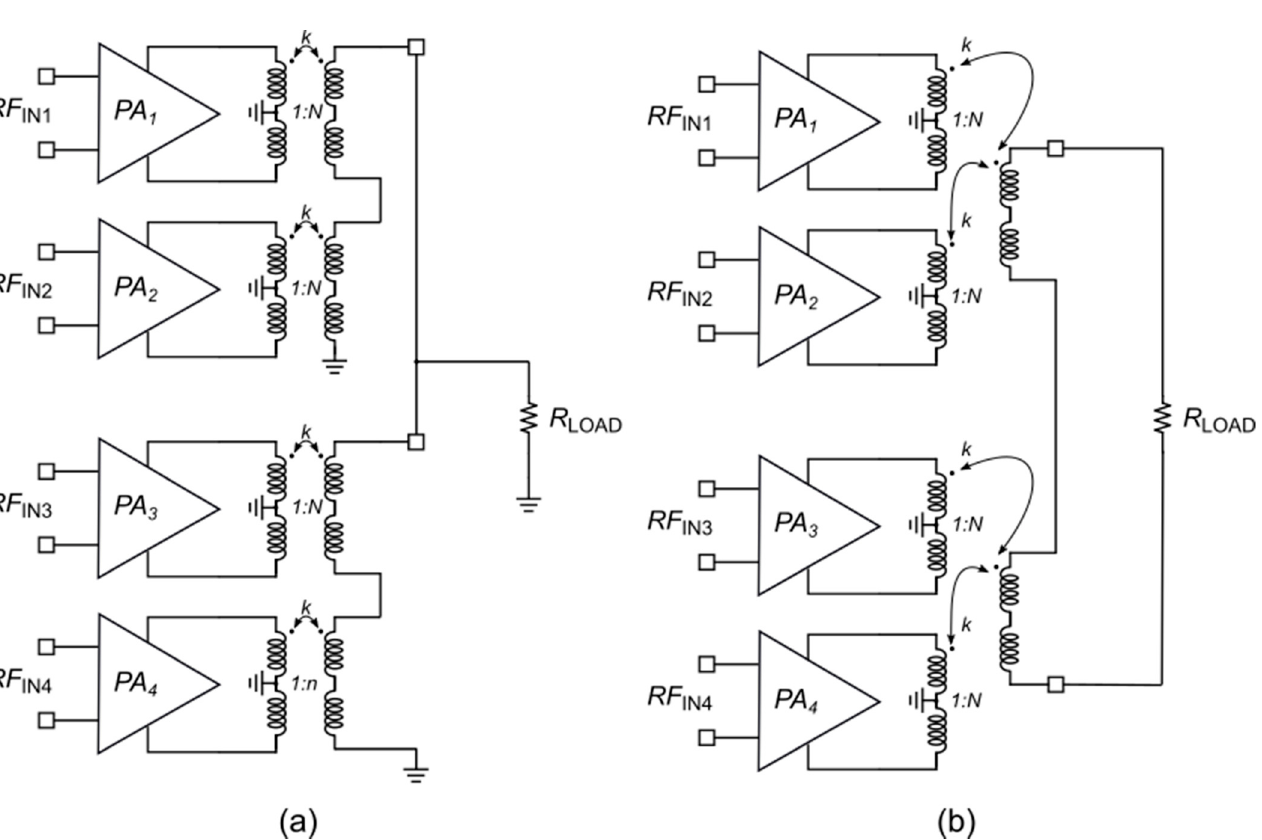
Figure 9. Power-combining techniques ( a ): voltage–current combining (SPCT); ( b ) current–voltage combining (PSCT). combining